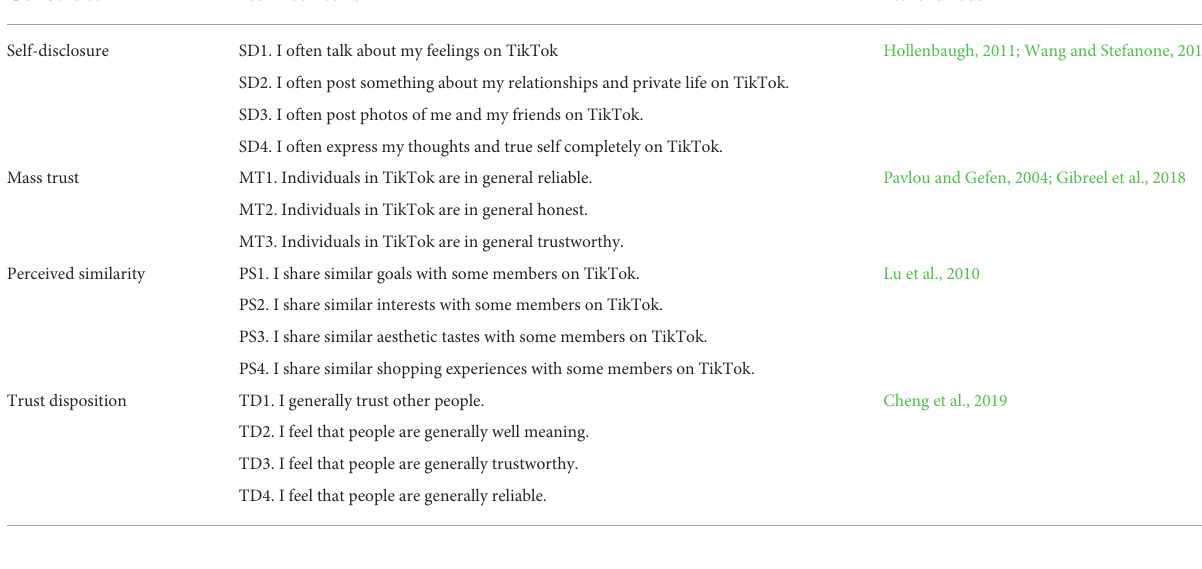
TABLE 3 Outer model